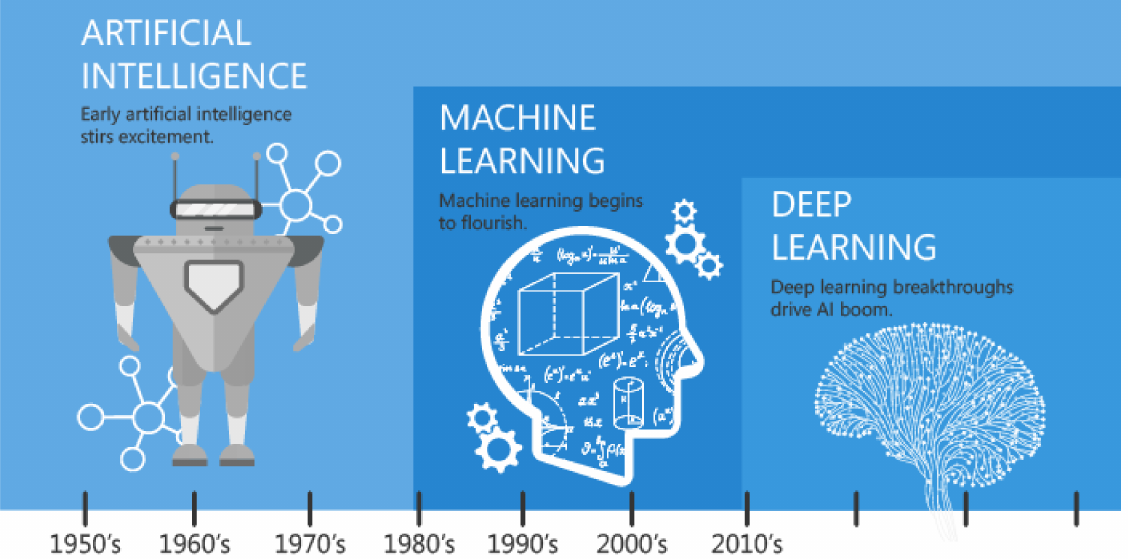
Figure 1. Evolution of Artificial Intelligence